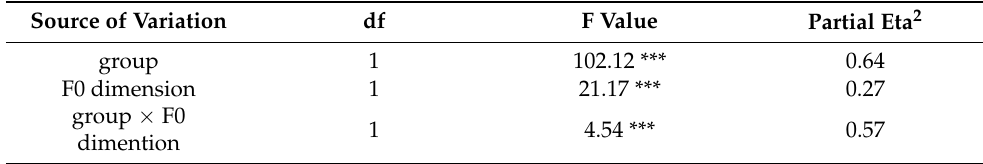
Figure 4. JNDs as a function of F0 dimensions in the CI and NH groups. Error bars indicate standard errors. The level of significance is indicated with asterisks (**: p < 0.01; ***: p < 0.001). Table 3. Summary of the ANOVA results.